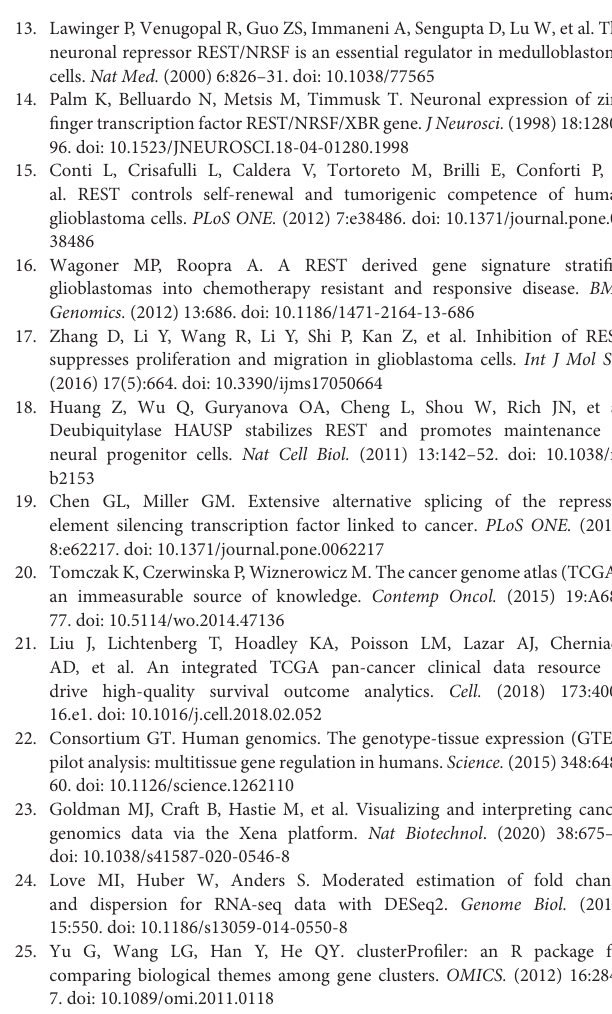
Supplementary Figure 1 | The protein expression of REST in glioma and normal samples using HPA. (A,B) The immunohistochemical results of REST protein of two antibodies of glioma and normal tissues were obtained from HPA. (C) Statistical column stacking diagram of REST staining in HPA. Supplementary Table 1 | The sequences of the primers or siRNA used in this study. GAPDH and U6 served as endogenous controls for mRNA or miRNA,